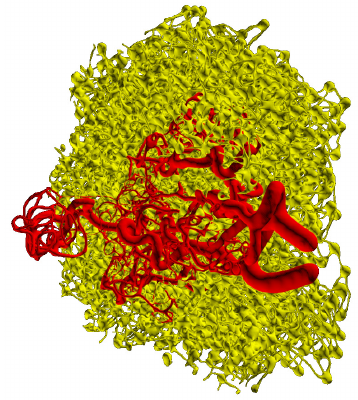
Figure 6. Integrated model of vascular vessels and FRC network (for a sphere of about 200 µ m).